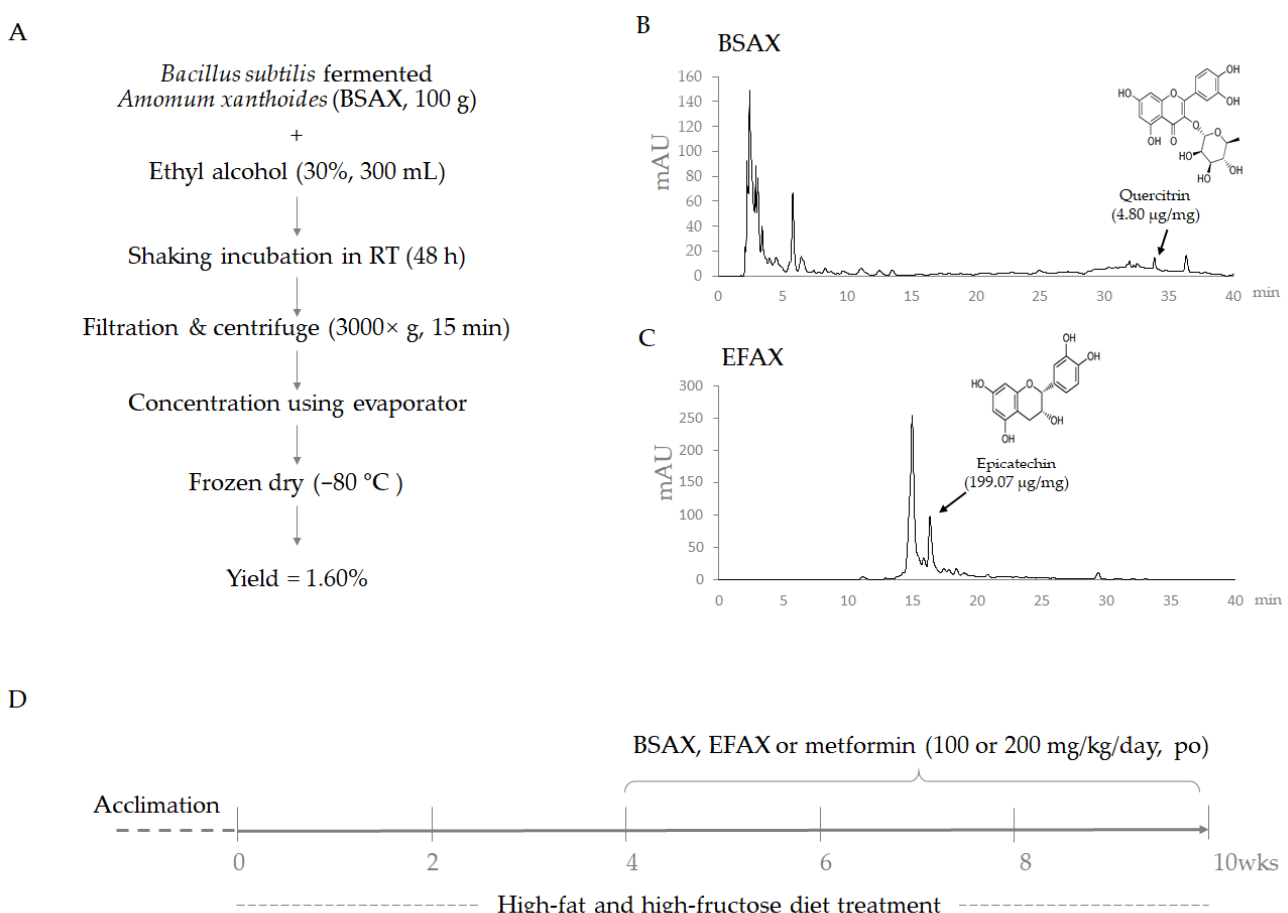
Figure 1. Procedure for obtaining the herbal extract, HPLC fingerprinting, and the experimental scheme. ( A ) Flowchart of the Bacillus subtilis -fermented Amomum xanthioides extraction (BSAX) process. ( B , C ) HPLC fingerprinting of BSAX and the ethyl acetate fraction of Amomum xanthioides (EFAX). ( D ) Animal experiment schedule.